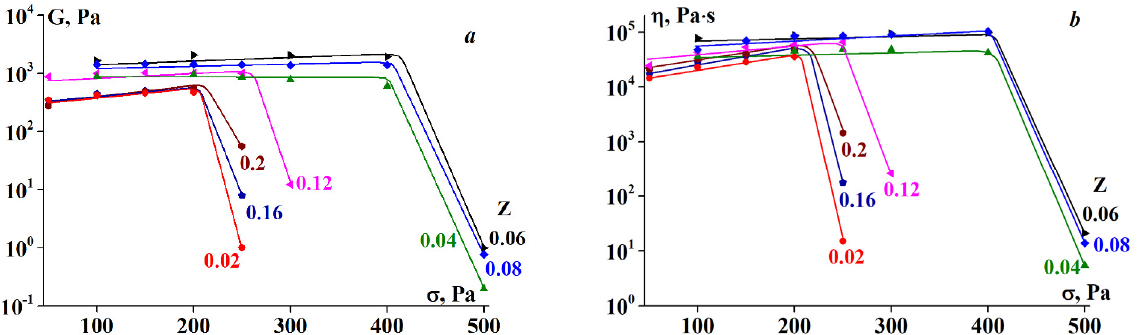
Figure 9. Dependence of ( a ) elastic modulus and ( b ) shear viscosity on shear stress at T = 4 °C. Z values are shown on the curves.